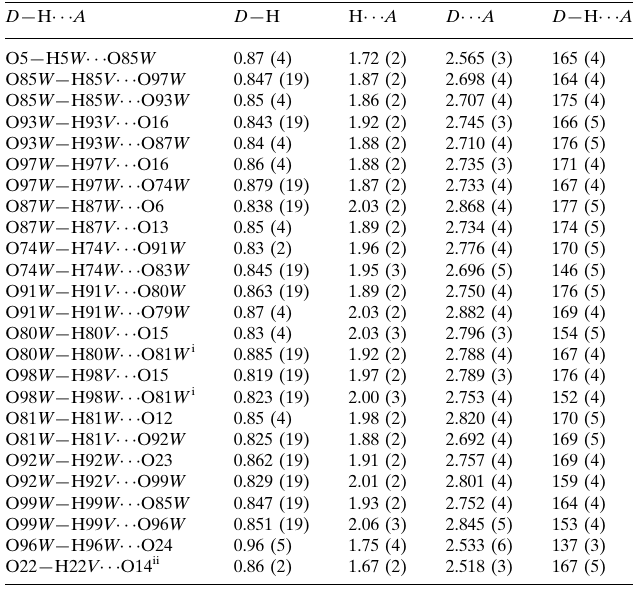
with 10782 Friedel pairs Flack parameter: 0.105 (6) Hydrogen-bond geometry (A˚ , (cid:2) ). (C H O )- 2 9 4 6 D —H (cid:1)(cid:1)(cid:1) A D comprises two